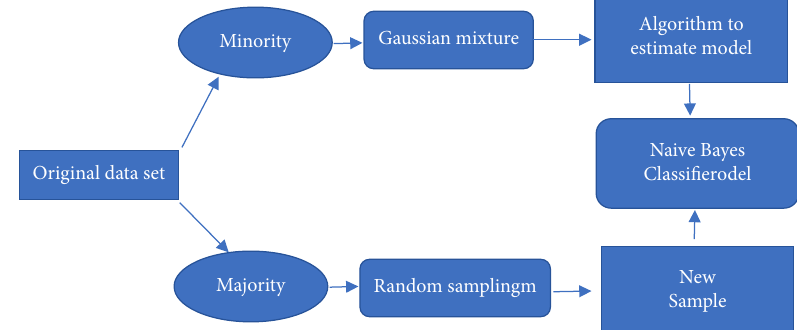
Figure 2: Data algorithm